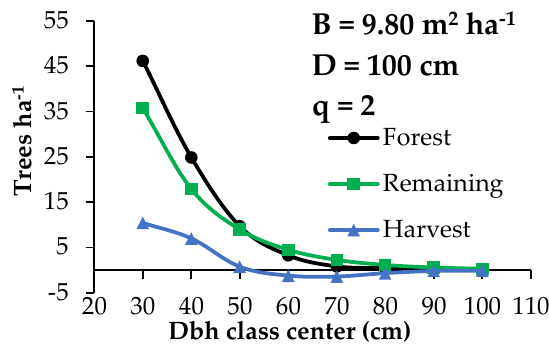
Figure 2. Balancing curves of the forest with the number of trees, per hectare, observed (forest), estimated using the BDq method (remaining) and destined for the commercialization of standing wood (harvest) by dbh class center, management area of the Fazenda Shet, Dom Eliseu, State of Pará, Brazil.